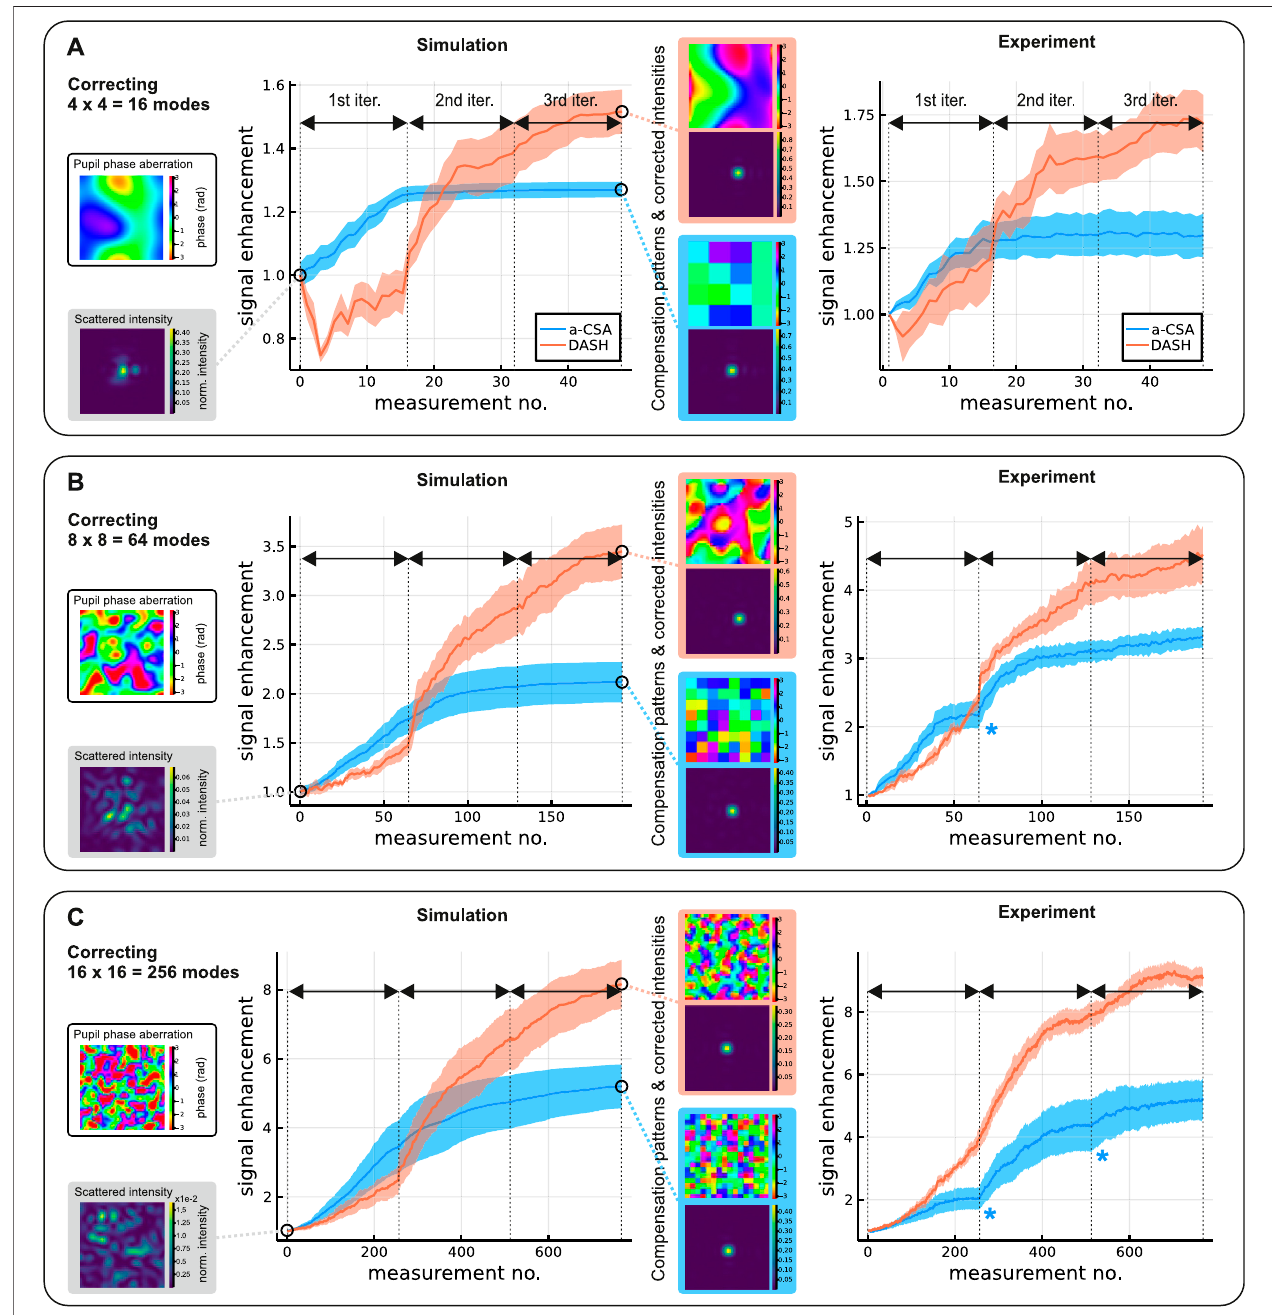
FIGURE4| Scattercorrectionindifferent turbidity regimes.ThethreescenariosA – Ccorrespondtoanincreasingdegreeofscatteringwith (A) L/l t =1, σ =1, (B) L/l t = 3, σ = 3, and (C) L/l t = 5, σ = 5, respectively. The left column shows examples of the phase aberration applied in the objective BFP and the resulting TPEF intensity distribution in the focal plane before correction. The plots in the center and right column show how the TPEF signal improves during correction in simulation (center) and experiment (right). Here, solid curves represents the mean value over 5 repeated runs in the simulation or experiment, each initialised with a different random scatterer, and the ribbons representthe respectivestandard errorofthemean. In particular, each plot point shown isthe result of P measured phase steps, where p =3 ( p = 5) in the simulation (experiment). For the simulations (center), insets show a fi nal SLM compensation pattern (respective top) and the corresponding object-plane intensitydistribution (respectivebottom) afterrunning theoptimizationalgorithms.Fortheexperimentaldata(right),kinksinthea-CSA curves(blueasterisks) arecaused by the circular, under fi lled pupil (see main text).